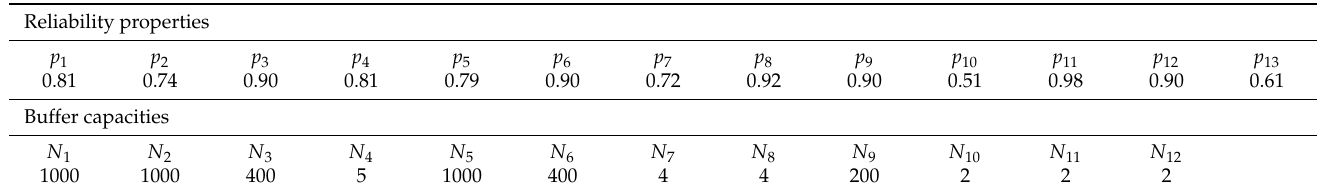
Figure 14. The power transformer’s active part assembly. Table 3. The reliability properties and buffering capacities acquired on the factory floor.